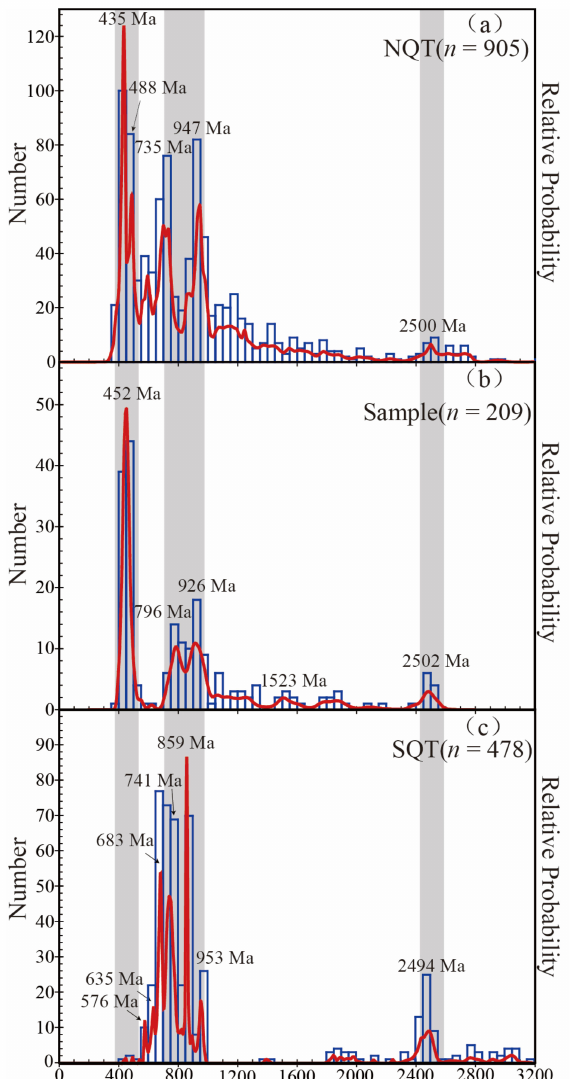
Figure 9. Relative probability diagrams of U–Pb ages for ( a ) NQT, ( b ) metasedimentary rocks of the Liuling Group and Wuguan Complex in this study, and ( c ) SQT. The data for the NQT and SQT are from [23,50,71,72] and [23,50,51,73–75],